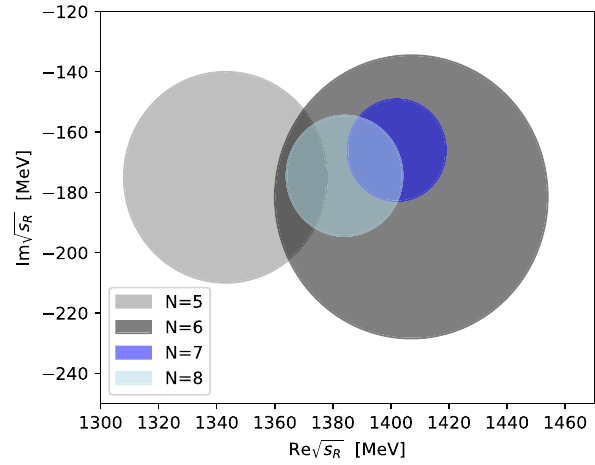
( 1950 ) in comparison to the 0